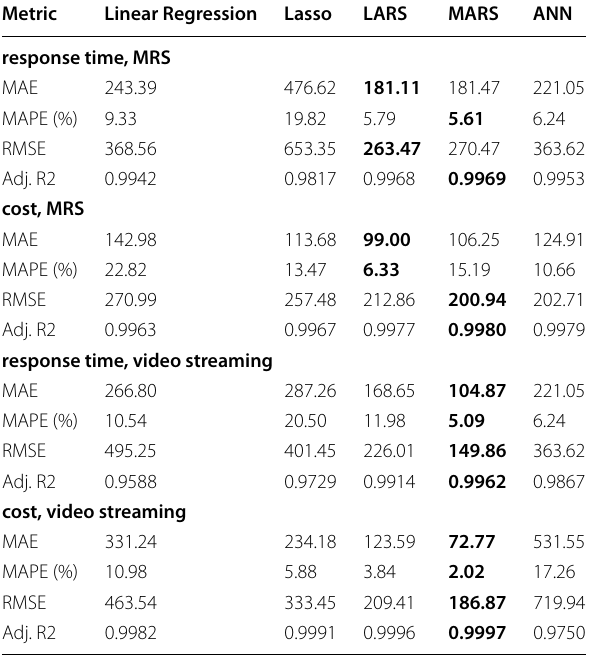
Table 5 Comparison of model accuracy. Best values for each model and metric are marked in bold print Metric Linear